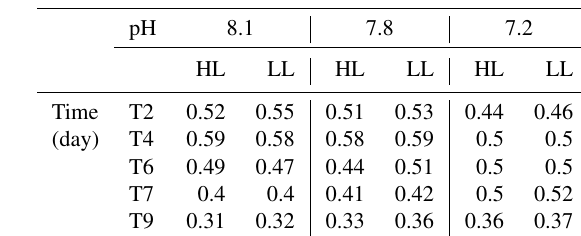
Table 5. F v /F m ratios for three different pH T measured on days T2, T4, T6, T7, and T9 under high light (HL) and low light (LL)